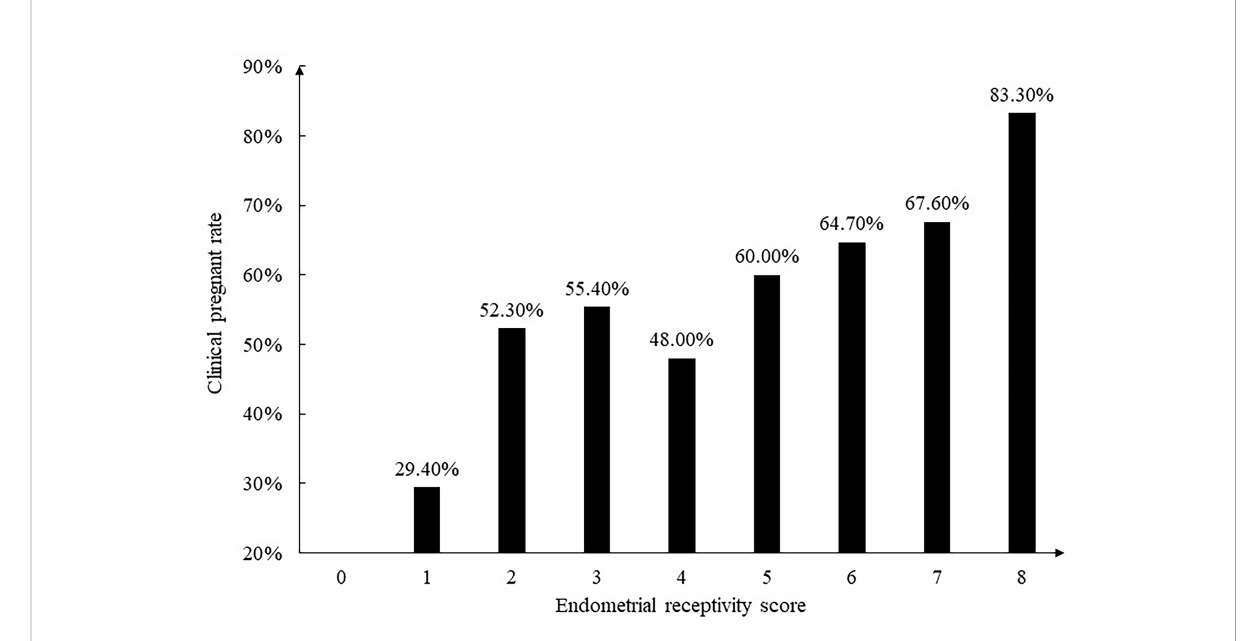
FIGURE 3 The relationship between endometrial receptivity score and clinical pregnant